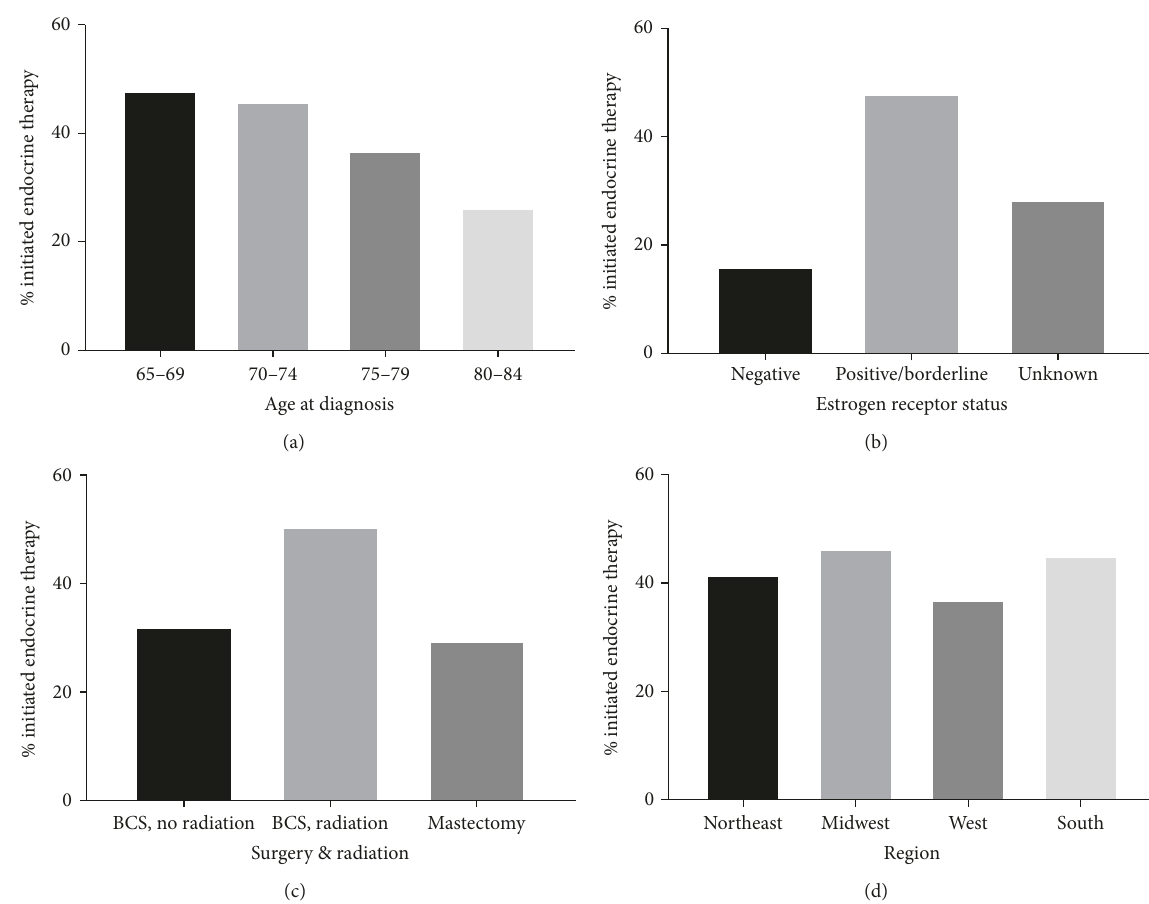
Figure 1: Endocrine therapy initiation among women aged 65+ years diagnosed with ductal carcinoma in situ during 2007–2011 in SEER- Medicare according to (a) age at diagnosis, (b) estrogen receptor status, (c) surgery and radiation, and (d)